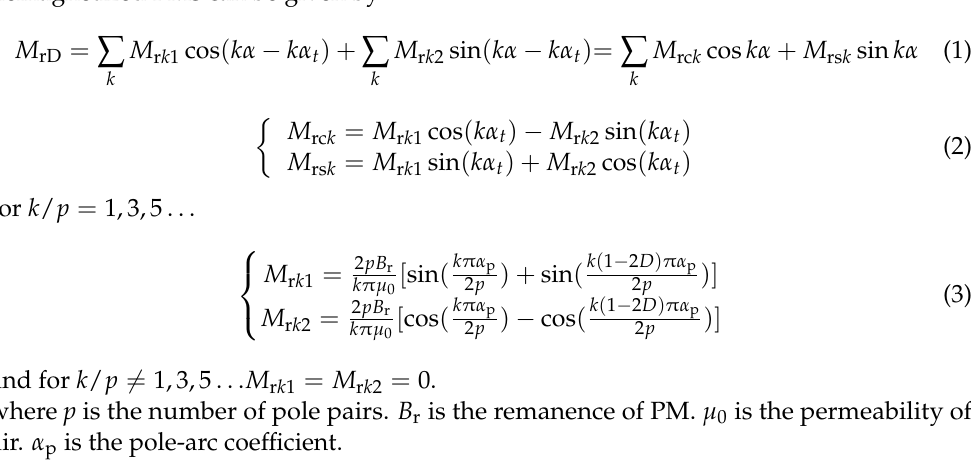
Figure 3. Magnetization of healthy PMs and uniformly demagnetized PMs (radial magnetization).